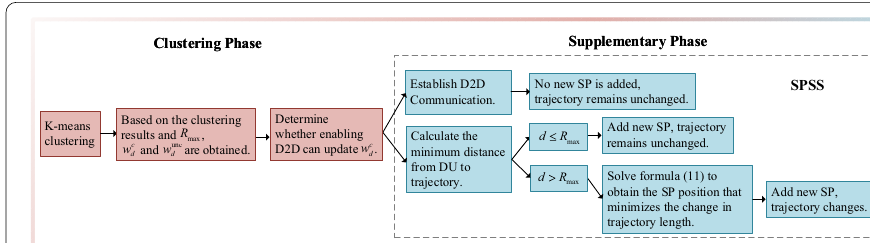
Fig. 3 Illustration of stop point selection strategy